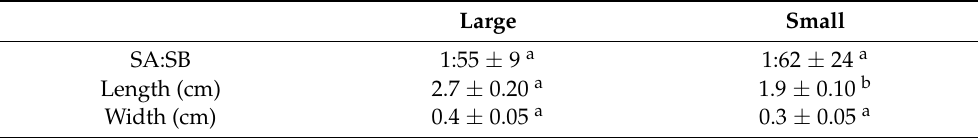
Table 6. Average nutrient composition of yellow mealworm at different ages (%).